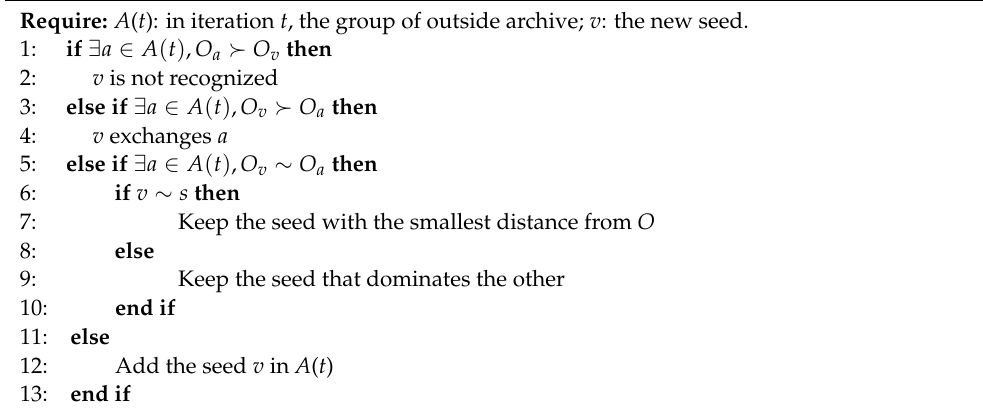
Algorithm 1. Refresh the archive population pseudo-code.